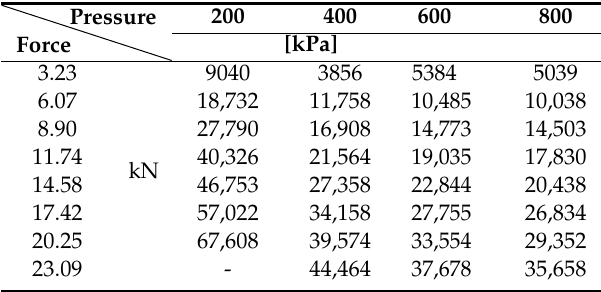
Figure 13. The envelope of one of the negatives (PZL M28 Skytruck / Bryza aircraft-pressure in the wheel 200 kPa, load 14.58 kN). Table 3. Surface area values resulting from testing the PZL M28 Skytruck / Bryza aircraft tire (results in mm 2 ).